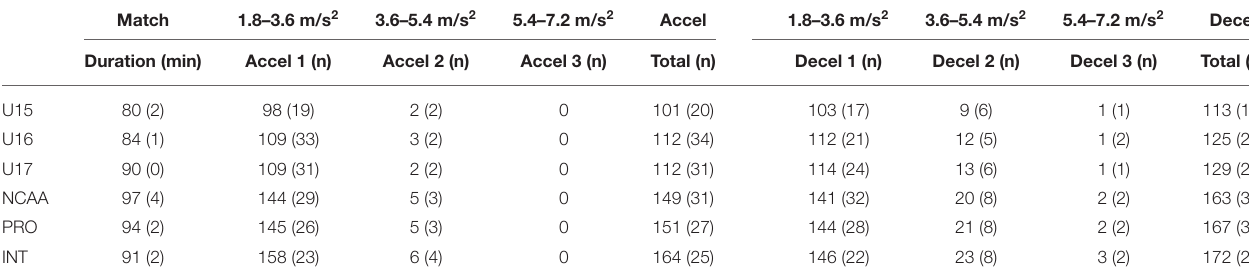
TABLE 3 | Acceleration and deceleration frequencies across